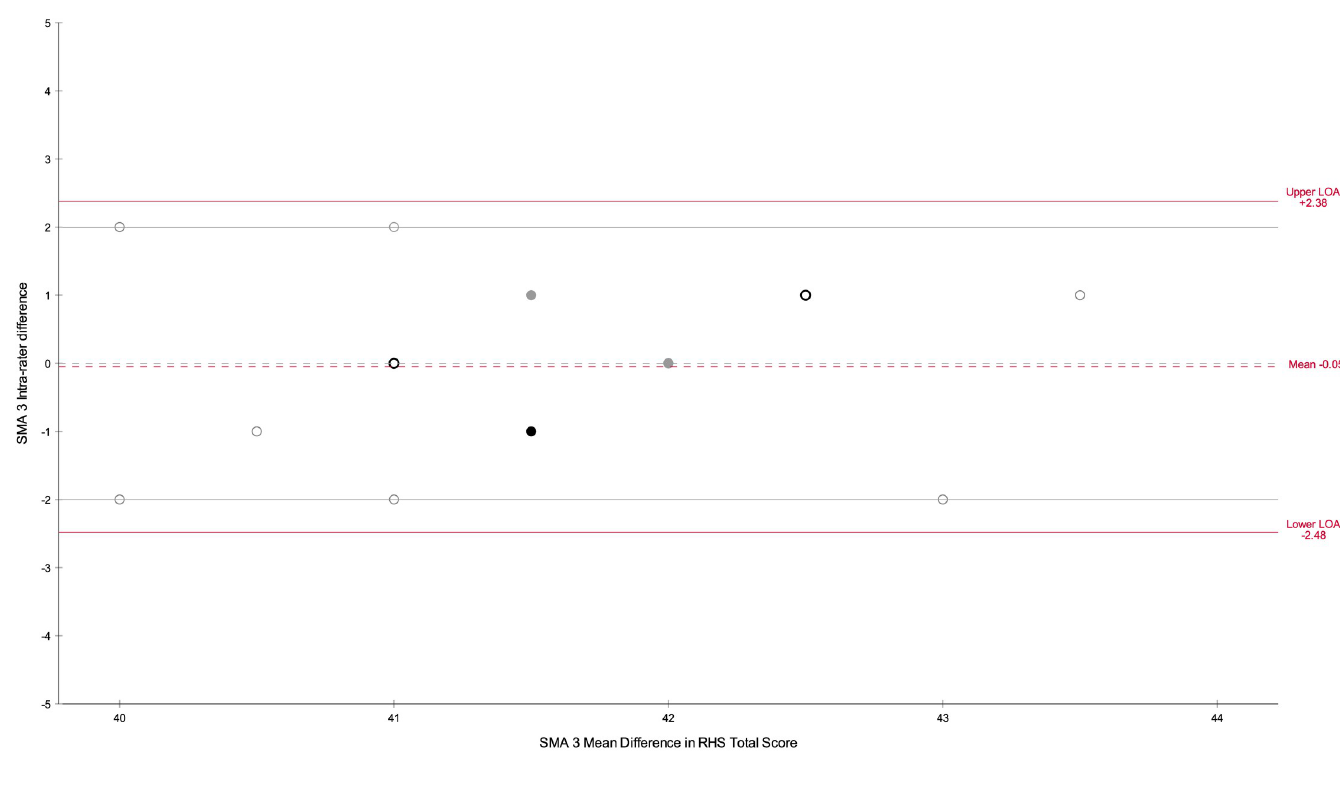
Fig 3. SMA 3 Intra-rater Bland Altman plot. Grey dotted line indicates 0 mean difference between tests, grey solid lines indicate the expert set limits of agreement. Dots– grey outline 1 rater, black outline 2 raters, grey filled dot 3 raters, black filled dot 4 raters.